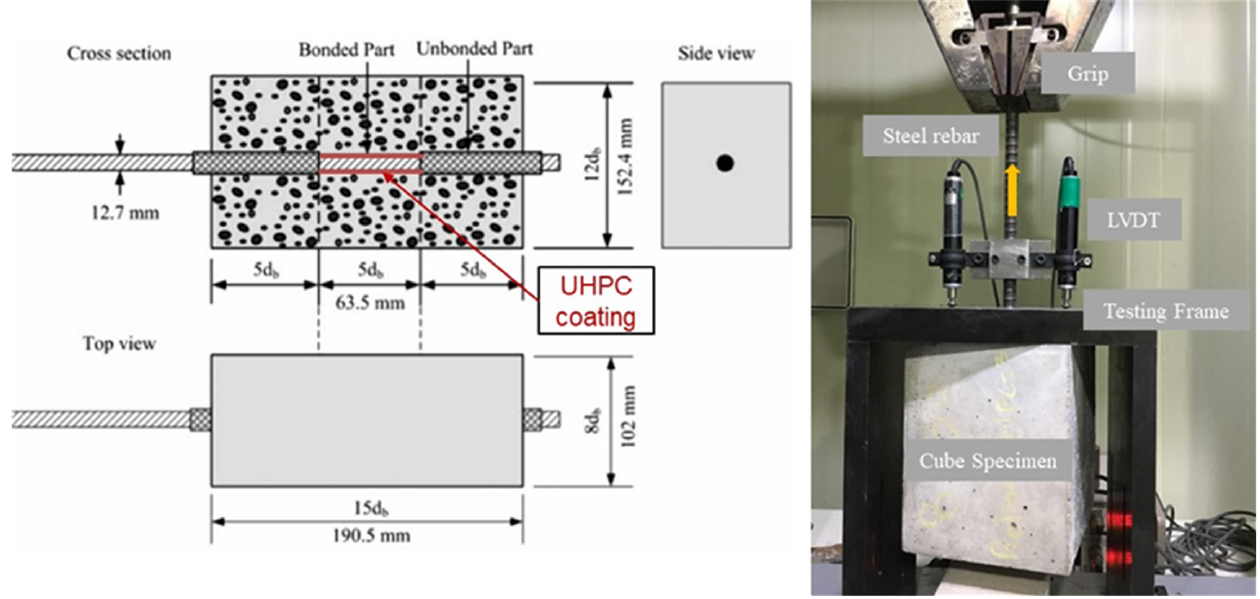
Figure 2. Specimen and testing setup.